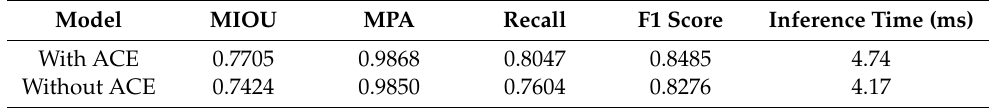
Table 2. Ablation study of the ACE module.